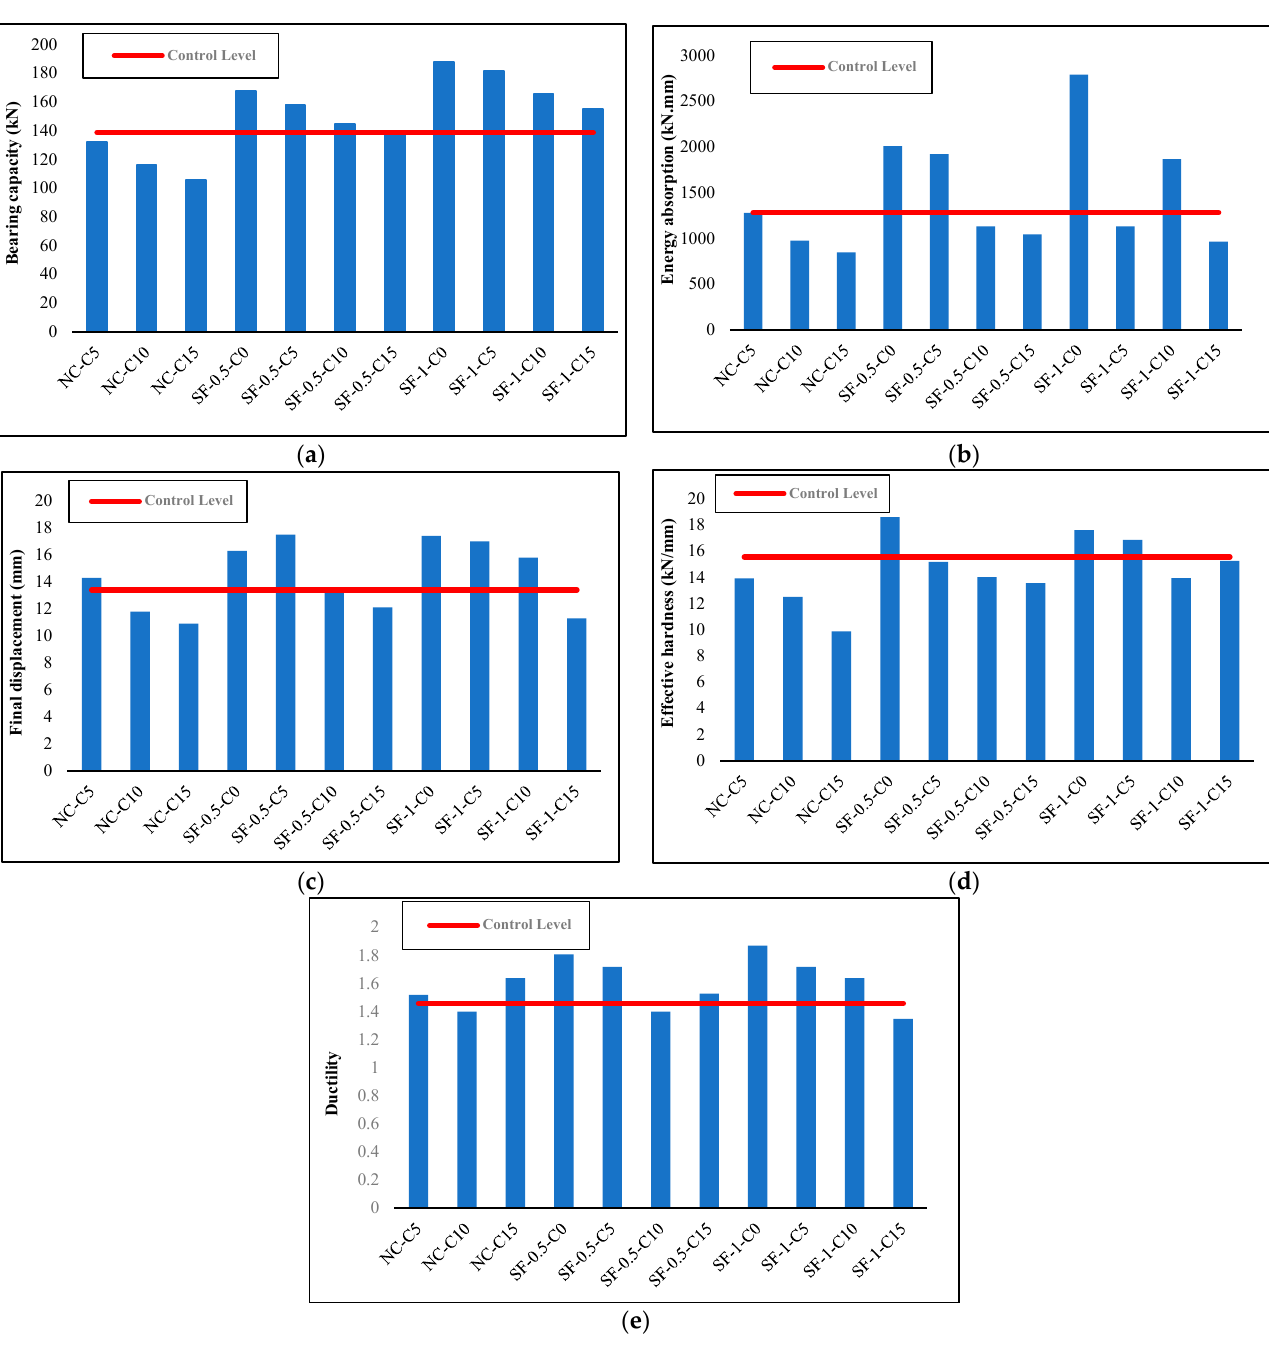
Figure 14. Comparative diagram of the change in ( a ) bearing capacity, ( b ) energy absorption, ( c ) final displacement, ( d ) effective hardness, and ( e ) ductility of the beams compared to the control specimen.